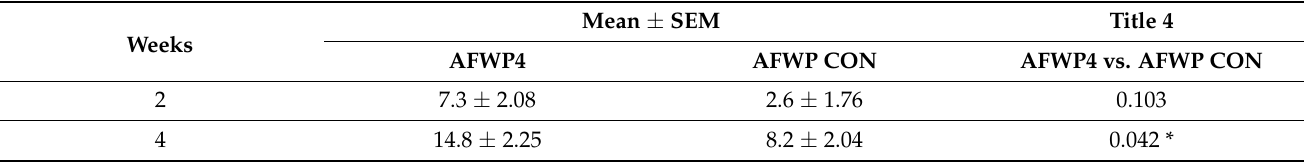
Table 5. Trans-epidermal moisture loss (TEWL) improvement rate